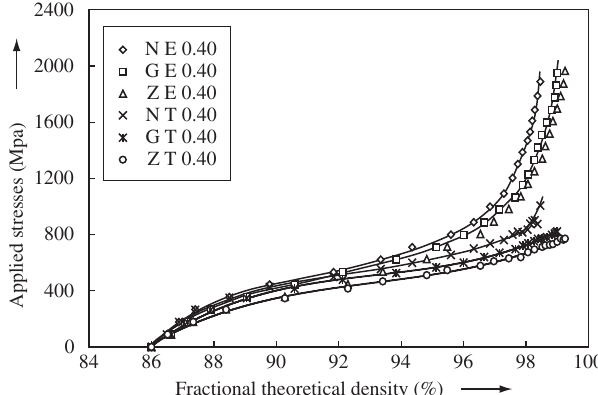
Figure 3. Relationship between applied stresses and the % fractional theoreti- cal density for Fe-0.8%C sintered P/M preform of 0.40 initial aspect ratio under the influence of lubricants. N: Nil lubricant, G: Graphite Lubricant, Z: Zinc Stearate Lubricant, E: Engineering Stress, T: True Stress. of Figure 2, the three different stages are more so following. At initial stages (from 86 to 88% theoretical density), the increase of stress rise is due to the resistance induced by the deforming